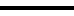
Figure 1. The Research Conceptual